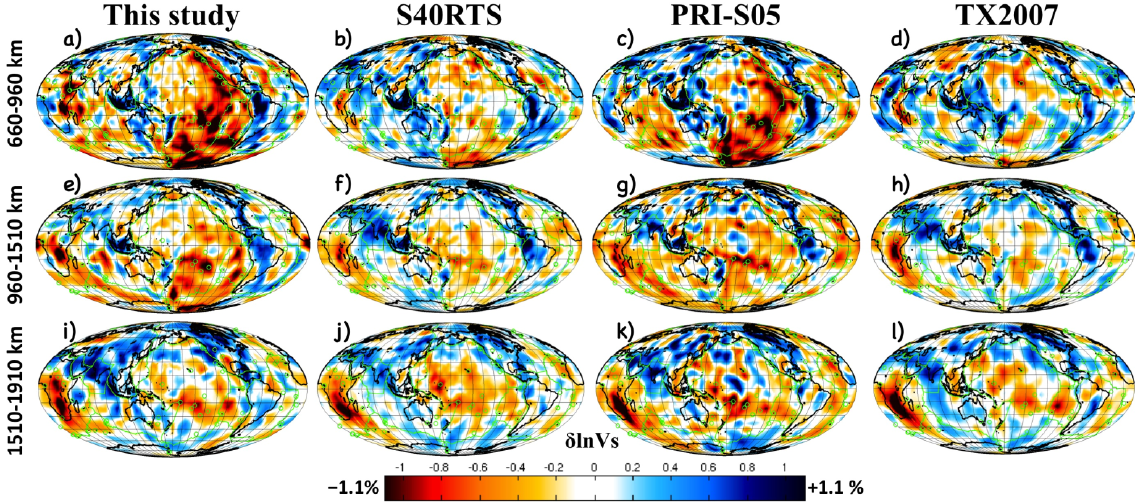
Fig. 7. Visual comparison of our model ( MB pref , left column) with three other global shear-velocity anomaly tomographic models (S40RTS, PRI-S05, TX2007), displayed in mid lower-mantle with respect to IASP91 and after projection onto our model parameterisation.